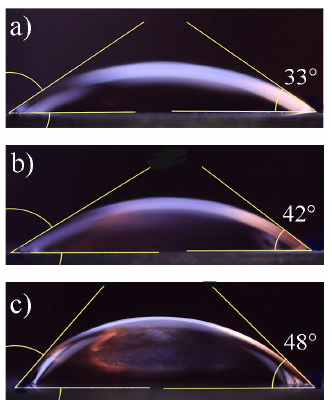
Figure 7. Contact angle measurements for carbon steel immersed in: ( a ) 1 M HCl for 1 h; ( b ) 1 M HCl with 50 ppm PN for 1 h; ( c ) 1 M HCl with 50 ppm PN for 4 h.